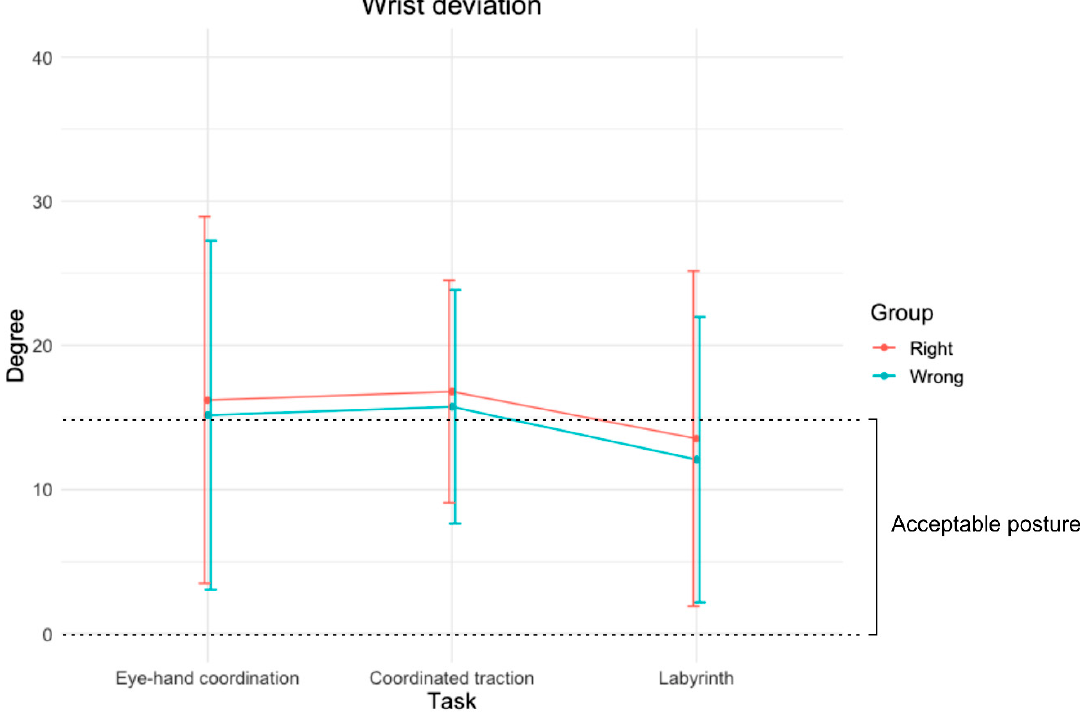
Figure 8. Flexion-extension of the surgeons’ wrist during the laparoscopic tasks using the right and wrong size of instrument handle. The graph indicates the acceptable posture of the wrist according to RULA method.